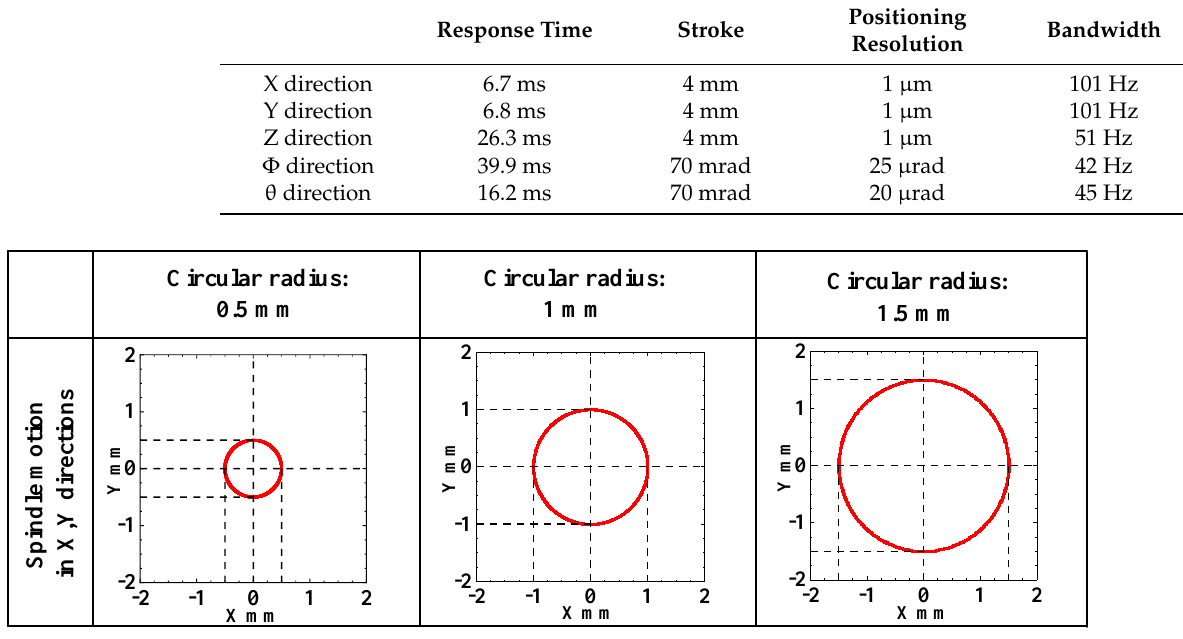
Figure 17. Spindle circular motion.